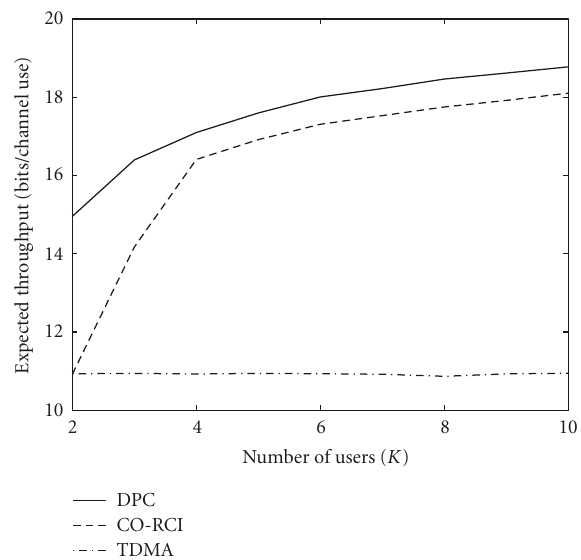
Figure 1: Expected throughput versus number of users for fixed N r = N t = 4 antennas and P = 10 in Rayleigh, flat-fading channel model. All nodes have perfect channel knowledge for all realizations of the